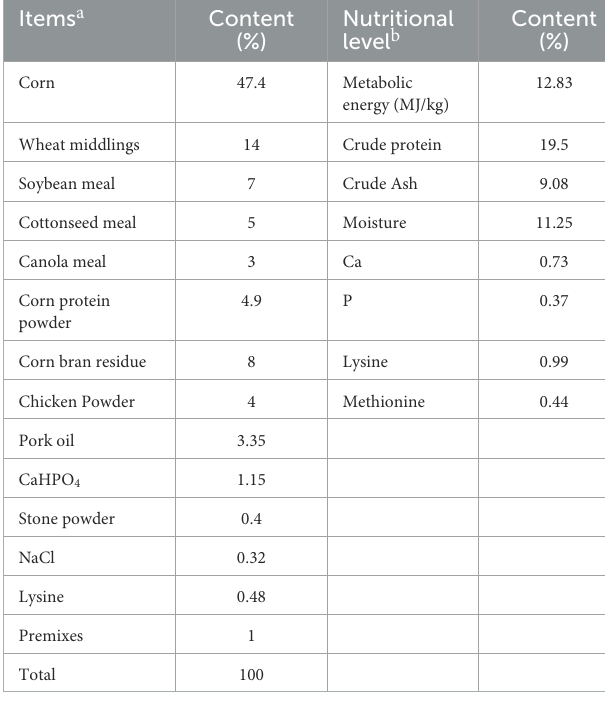
TABLE 1 The ingredient composition of the basal diet and nutrient